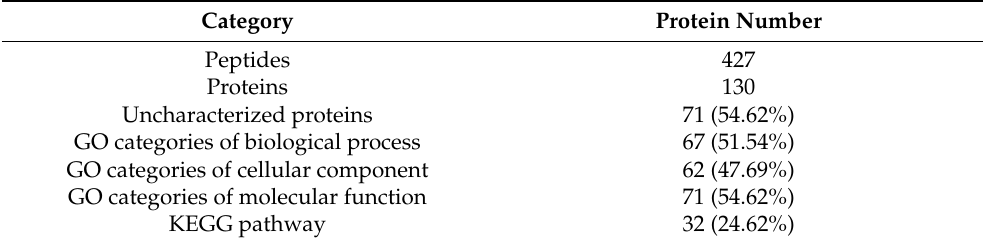
Table 1. Overview of protein identification, annotation, and enrichment analysis.